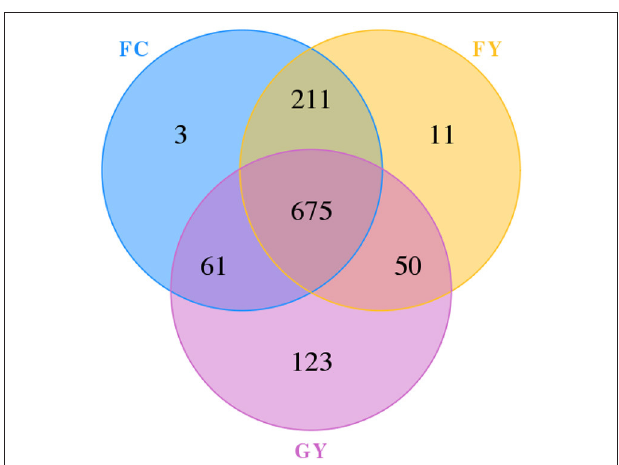
FIGURE 2 | Ruminal operational taxonomic unit (OTU) of bacteria in GYs, FC, and FYs.